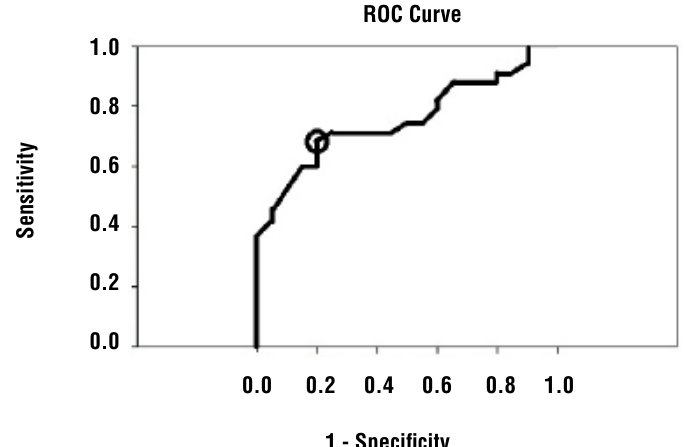
Figure 1 - Cut off value serum CA 19-9 as deduced from ROC Curve.